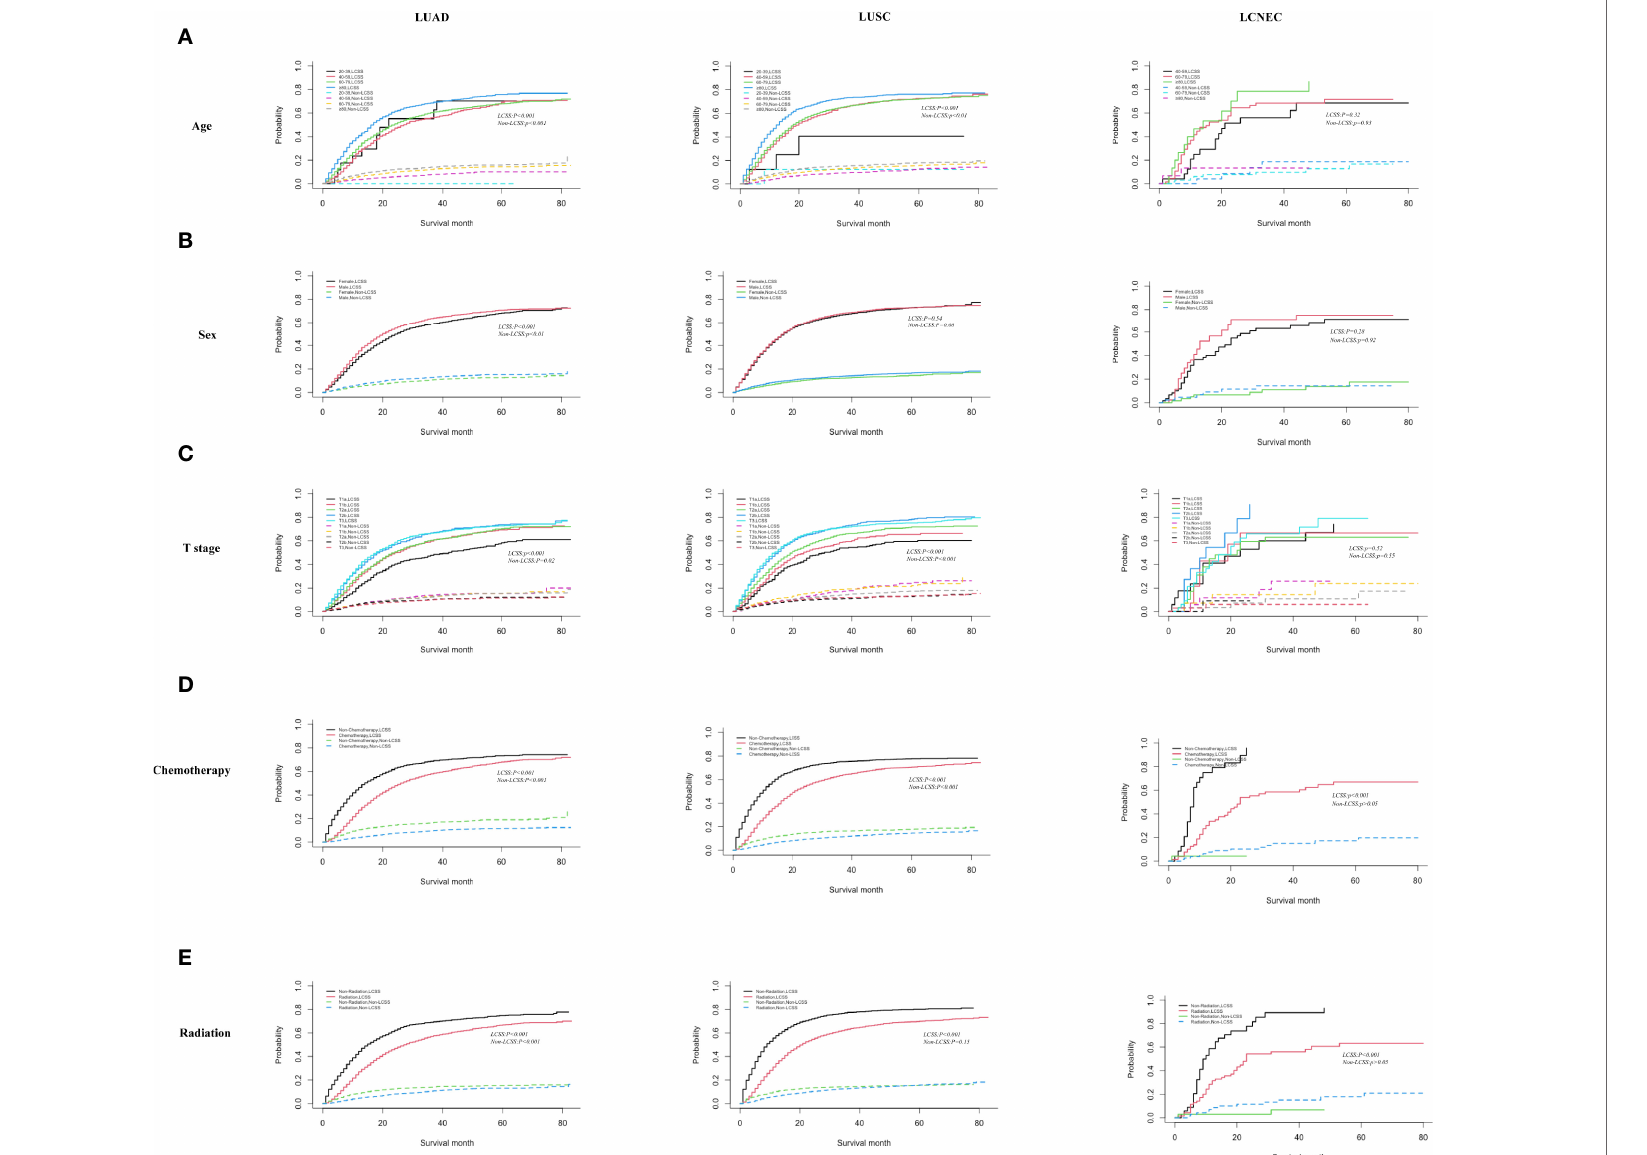
FIGURE 3 | Competing risk analyses for patients in the LUAD, LUSC, and LCNEC group according to (A) age, (B) sex, (C) T stage, (D) chemotherapy, and (E)